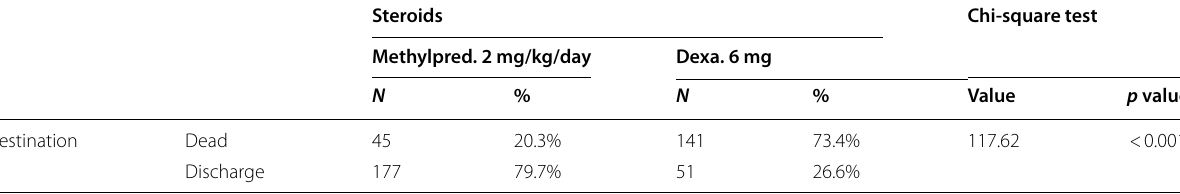
Table 5 Destination of the studied